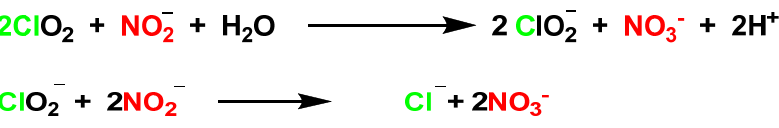
Figure 26. Oxidation of nitrite NO 2 − by ClO 2 .